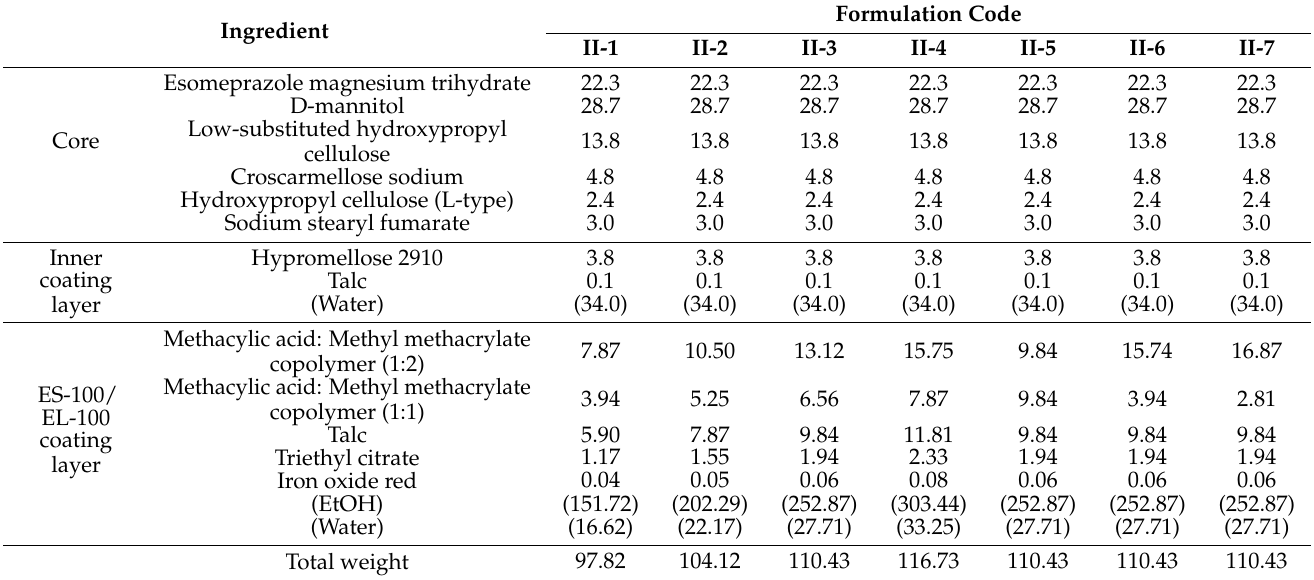
Table 3. Composition of EMP loaded ES-100/EL-100 coating mini-tablet as 2nd release mini-tablet. (Amount per capsule containing 10 mini-tablets, unit: